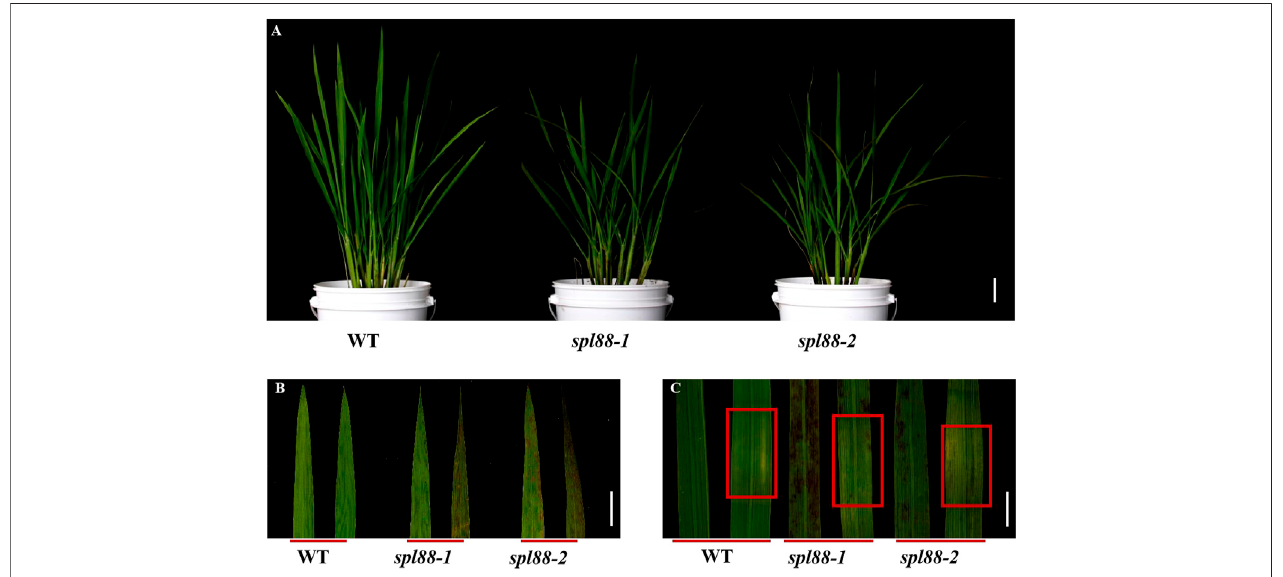
FIGURE1| Phenotypicanalysisofthewildtypeandmutantplants. (A) Phenotypediagramofwildtypeandmutantplants;Bar=15 cm. (B) Leafphenotypeofwild type and mutant plants; Bar = 3 cm. (C) Phenotype of wild type and mutant plants before and after shading; Bar = 2 cm.